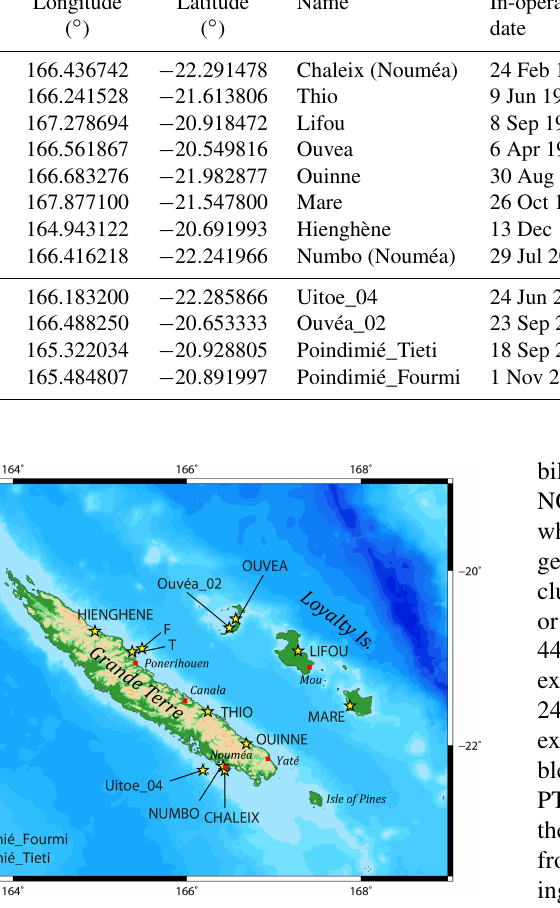
Figure 5. New Caledonia tide and pressure gauges (yellow